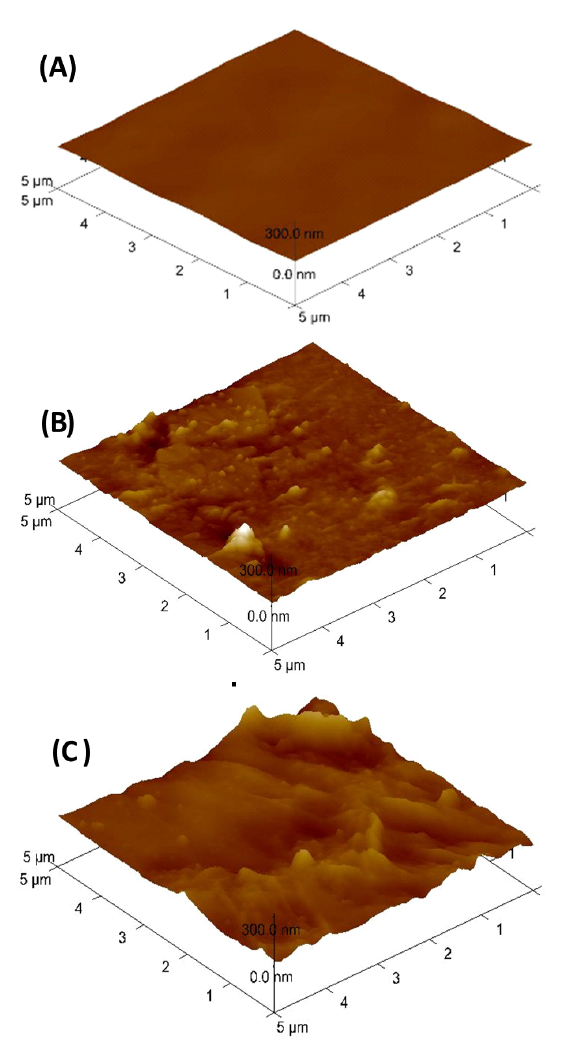
Figure 4. AFM images: neat aramid ( A ); ArGr composites ( B ); ArGrO composite( C ) both with 8 wt.% Grs.